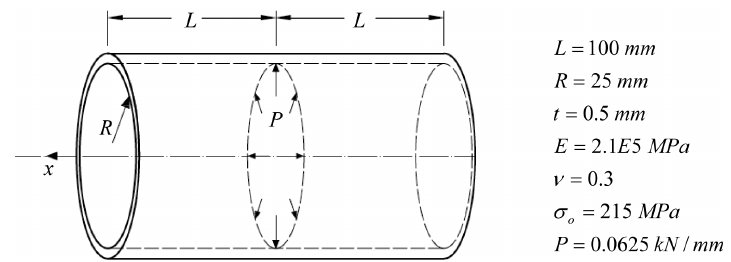
Fig. 14. Cylindrical shell subjected to a ring of pressure.